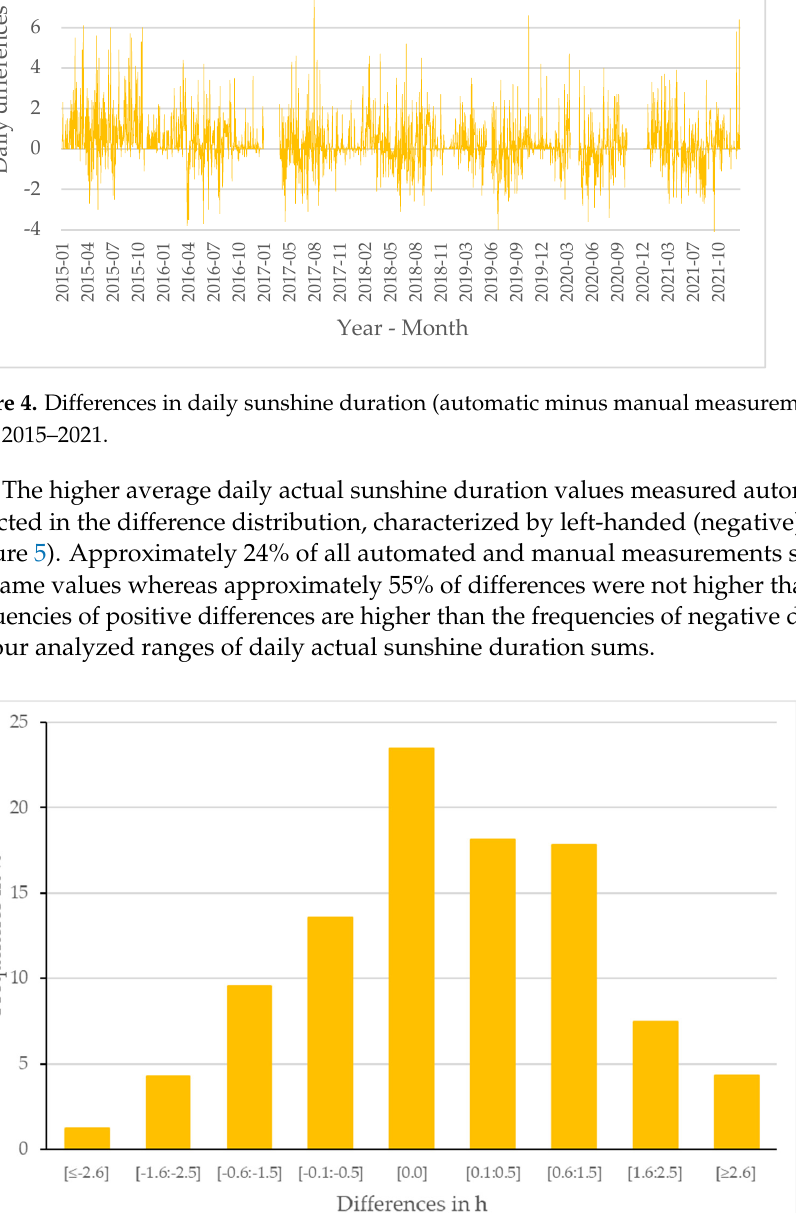
Table 1. Monthly frequency of daily differences in sunshine duration from manual and automatic measurements in Borucino, 2015–2021. Hours